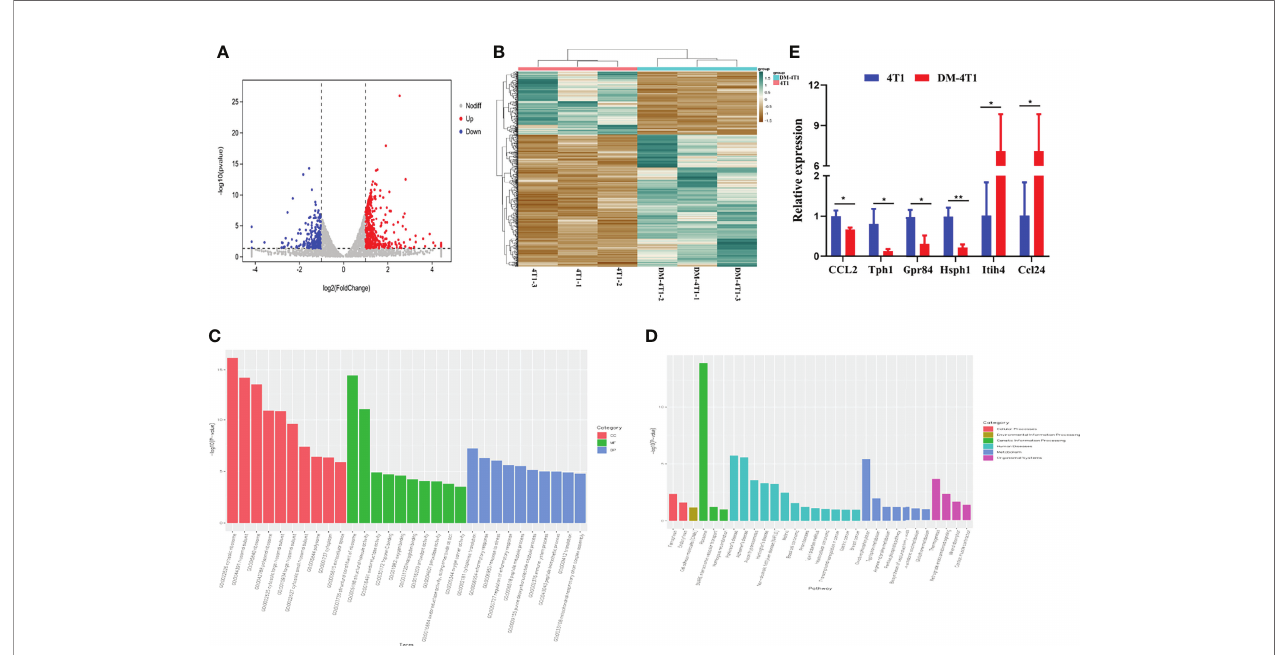
FIGURE 5 | STZ-induced DM changed the transcriptome of tumor. (A) Volcano plot showed the changes of gene expression. The red dots indicate up regulation. The blue dots indicate downregulation. The gray dots indicate no signi fi cant difference. (B) The heat map of DM-4T1 versus 4T1 group. Transcript enrichment was encoded in the heat map from low (green) to high (red). The color bars at the top of the heat map indicated the clusters in two groups. (C) Top 10 GO categories were analyzed according to – log10 ( p values). GOs included biological process (BP), cellular component (CC), and molecular function (MF). (D) A Bar diagram of the top 20 ranked KEGG pathways of DEGs. In the bar diagram, colors indicated different category. (E) Further validation of the RNA sequencing results using qRT-PCR. * p < 0.05, ** p <